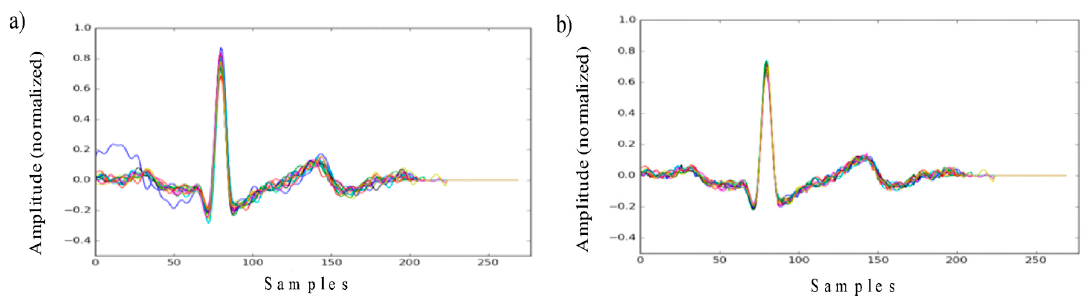
Figure 3. ECG segments (heart beats) aligned to the R peak ( a ) before and ( b ) after the outlier correction.